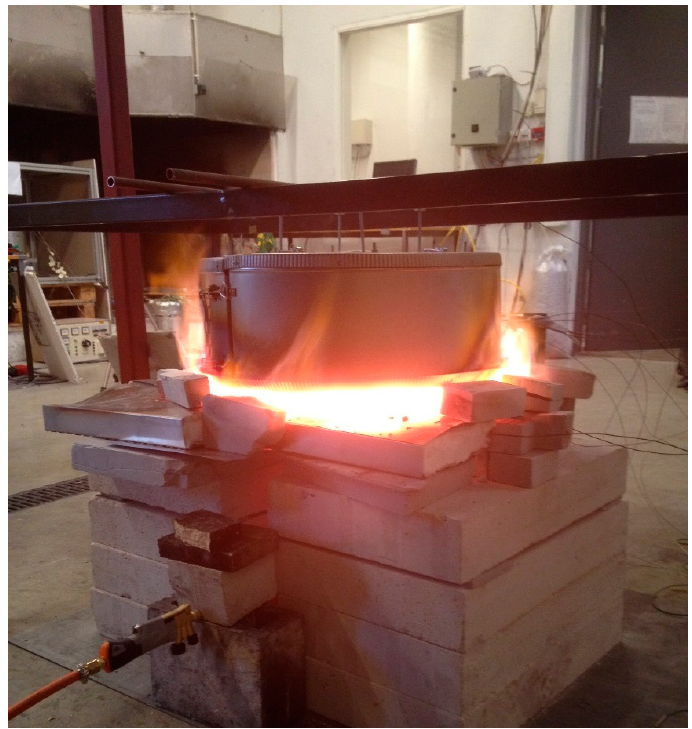
Figure 9. Test 2. (Air flow restrictors removed for visual inspection 30 s before test completion.)